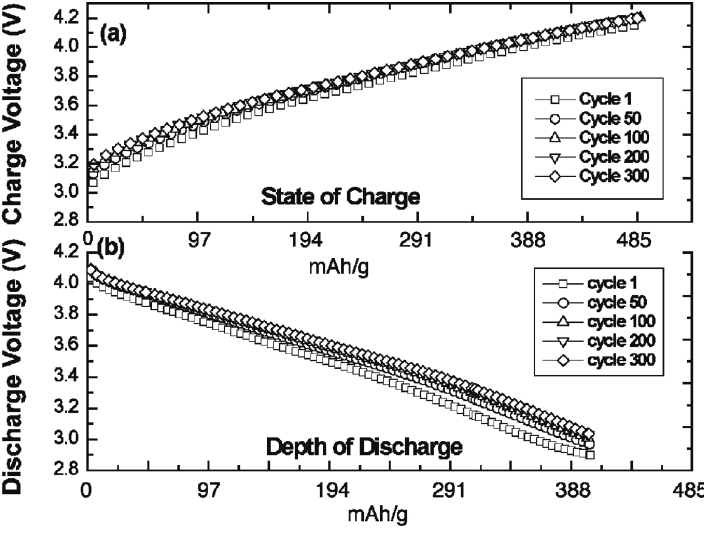
Figure 1. Extended galvanostatic cycling charge-transfer behavior for a super-iron Li battery containing a 191-nm thick Fe(III/VI) Na during charge and (b) cell potential during discharge. Charge/discharge cycle numbers are indicated. Results are detailed in Licht, Wang, Gourdin, Enhancement of Reversible Nonaqueous Fe(III/VI) Cathodic Charge Transfer, Journal of Physical Chemistry , C , 133 , 9884–9891